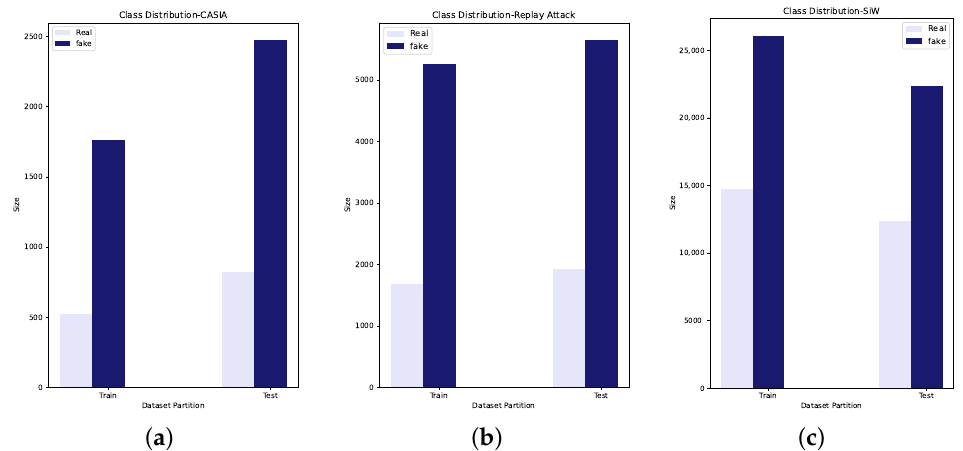
Figure 6. Test and train class distribution after image extraction from CASIA, Replay Attack, and Spoof in the Wild. ( a ) CASIA, ( b ) Replay Attack, ( c )